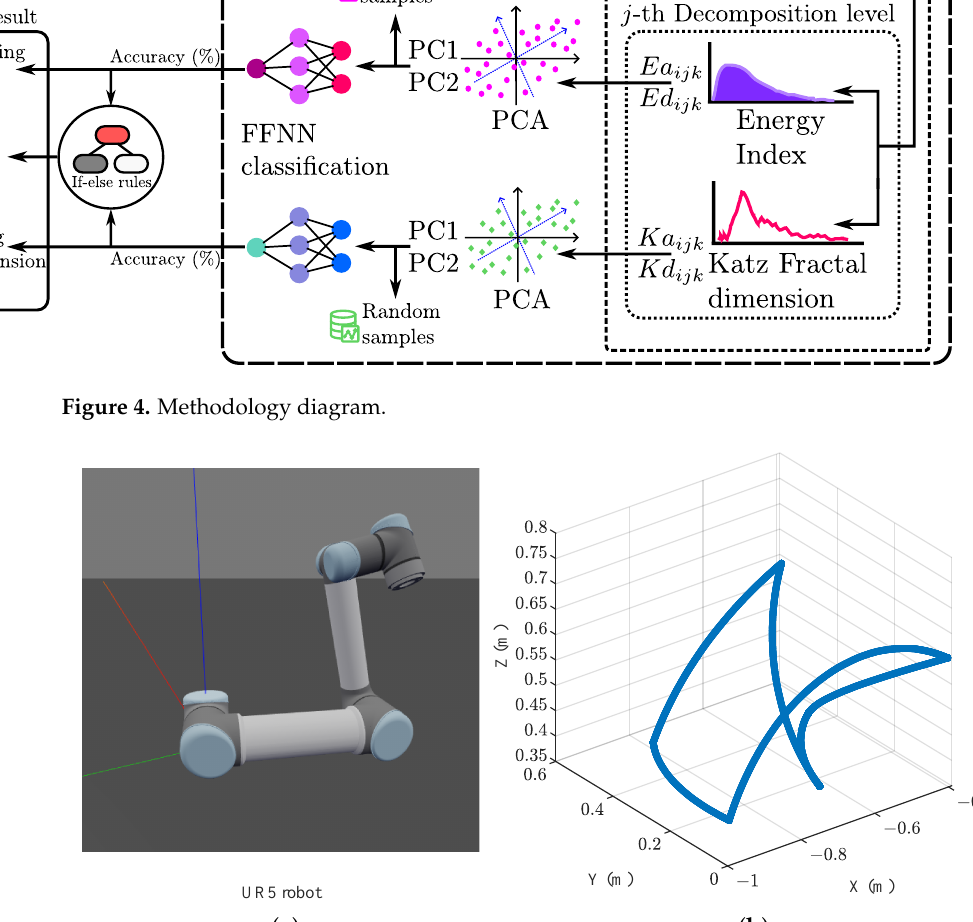
Figure 5. Robot and trajectory. ( a ) UR5 robot, image obtained using the library Robotics Toolbox for Python, available in [48]. ( b ) The trajectory followed by the robot in continuous